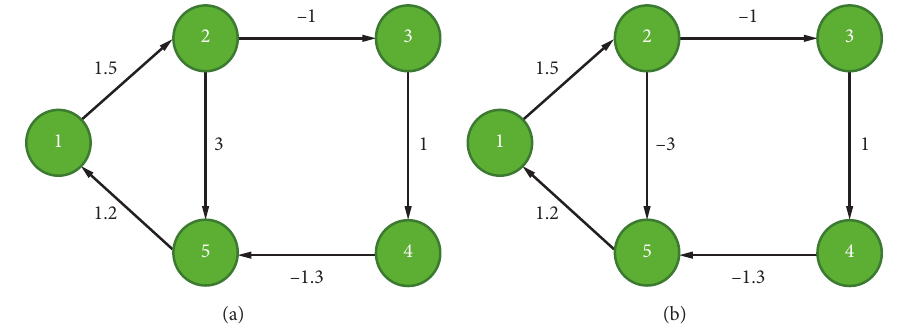
Figure 1: Strongly connected directed signed networks.